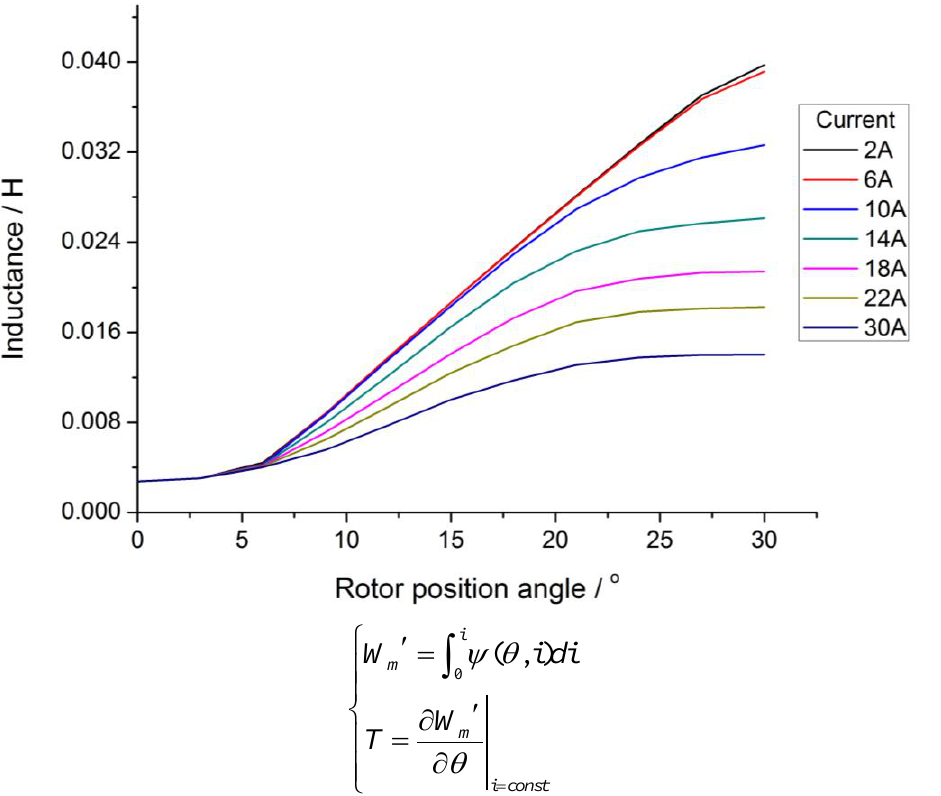
Figure 11. Inductance curves of stator winding.